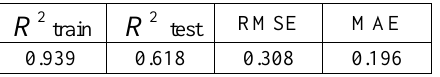
Table 1 . Results of Random forest